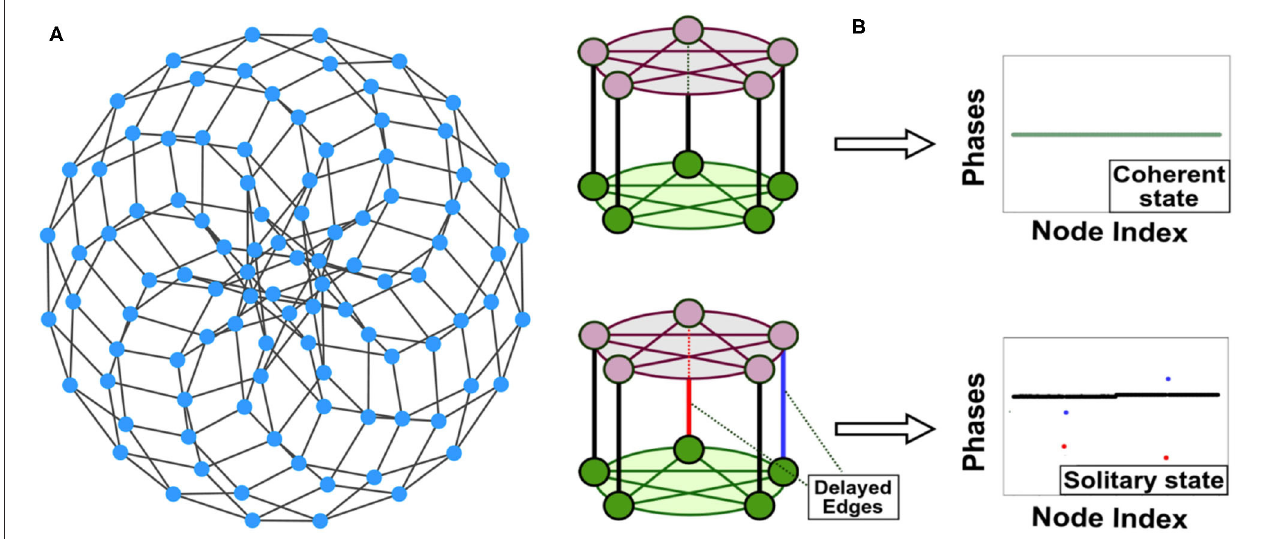
FIGURE 1 | (A) Schematic diagram of 100 identical nodes networked in a 2-D lattice formation assuming periodic boundary condition. (B) Schematic diagram of a multiplex network of two globally coupled networks having mirror inter-layer links. For a suitable choice of systems parameters, the state of multiplex network (B) demonstrating coherence for undelayed inter-layer links and (C) demonstrating solitary states in the presence of a few delayed interlayer